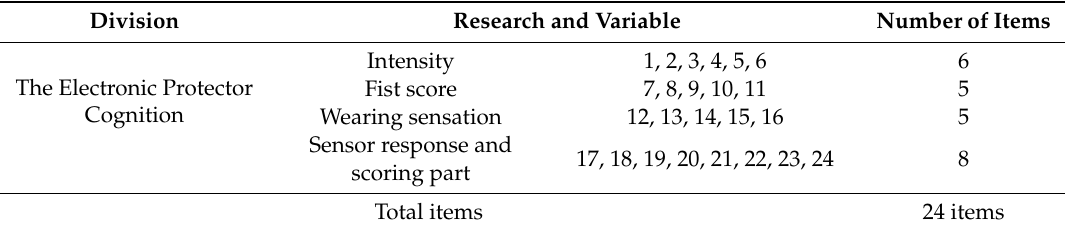
Table 3. The components of the